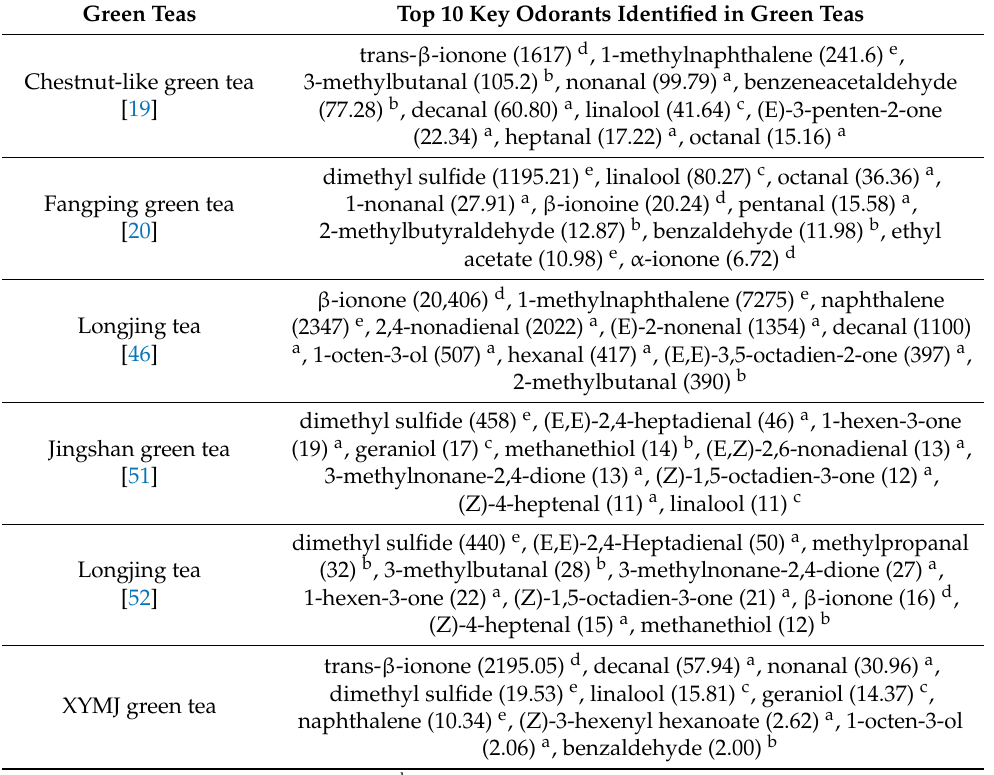
Table 4. The top 10 key odorants identified in the XYMJ and other green teas. Green